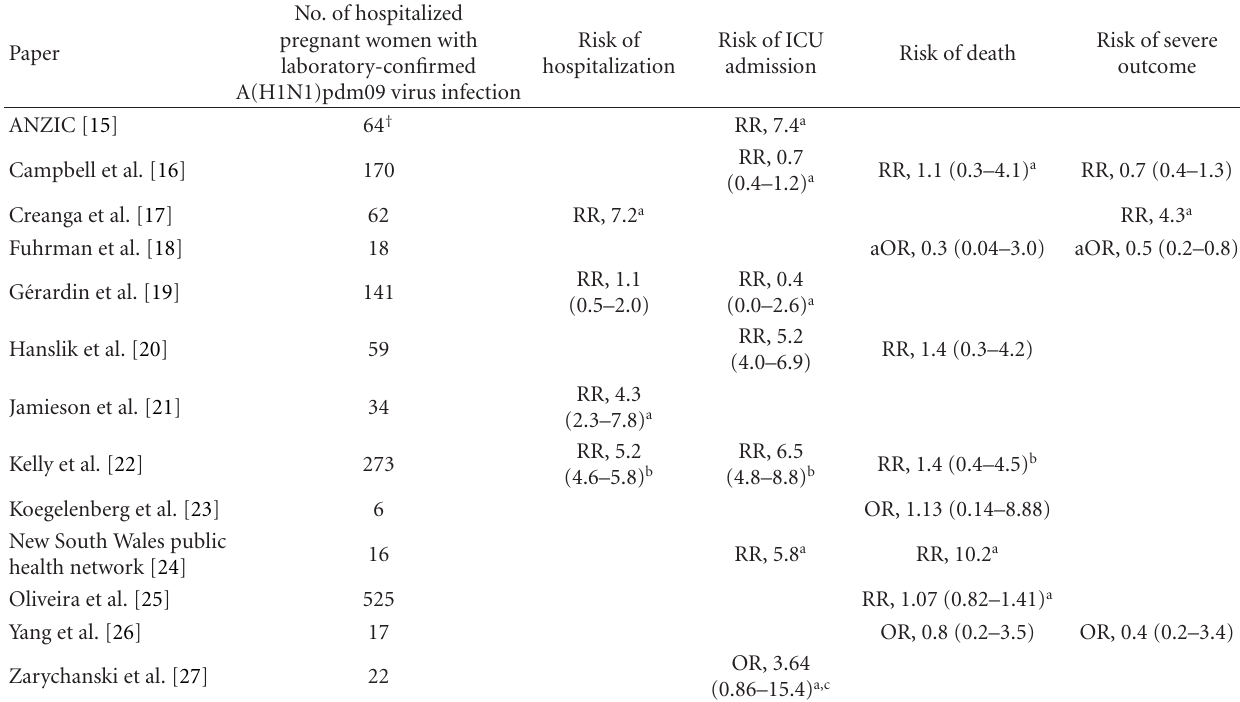
Table 1: Relative risk of hospitalization, intensive care unit admission, death, or any severe outcome in pregnant women due to 2009 H1N1